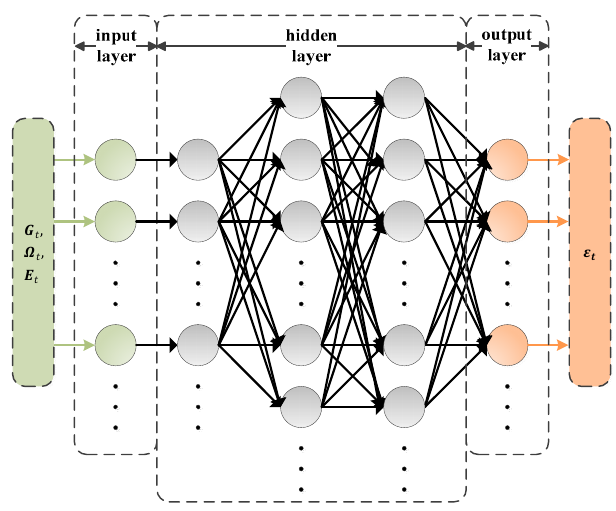
Figure 5. Designed architecture of DNN.